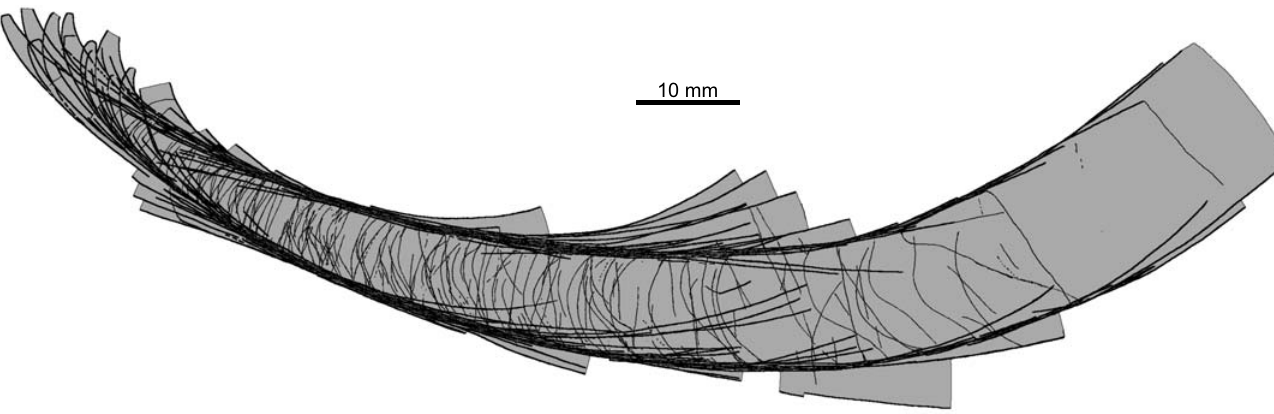
Fig. 10. Contours of all the ellesmeroceratid nautiloid conchs (interpreted below as Ruthenoceras elongatum Korde, 1949) from sample Ang-4, block No. 1, probably latest Furongian Ust-kut Formation found at Pashino on the Angara River, Siberia, Russia, superimposed on the most complete specimen ZPAL N. IV/4 (Fig.